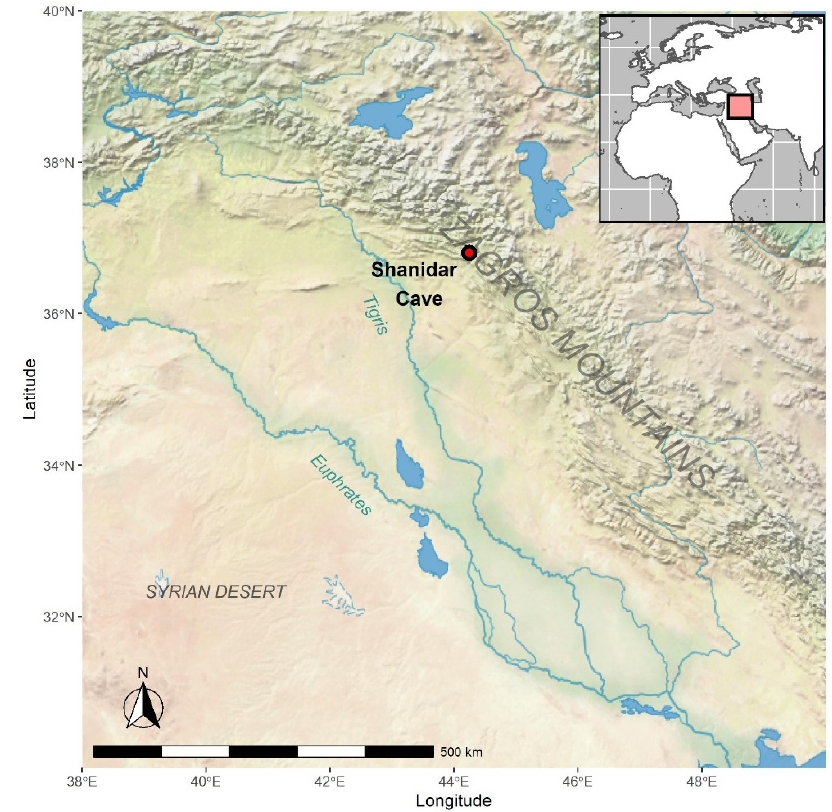
Figure 1. Map showing the location of Shanidar Cave. Map created in R using Natural Earth raster.